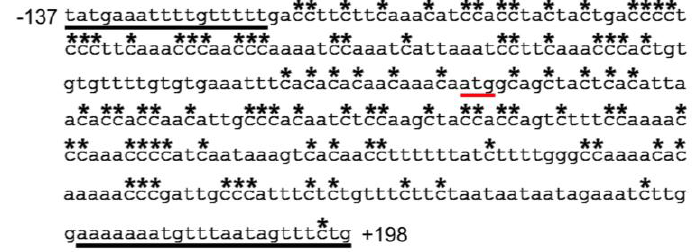
Figure 1. Nucleotide sequence of the genomic DNA fragment of the EPSP-synthase 1 gene of Conyza canadensis . Bases are numbered relative to the translation start site (red line) at position +1. Cytosine residues are marked with asterisks. Black solid lines indicate the primers used for amplification and sequencing.